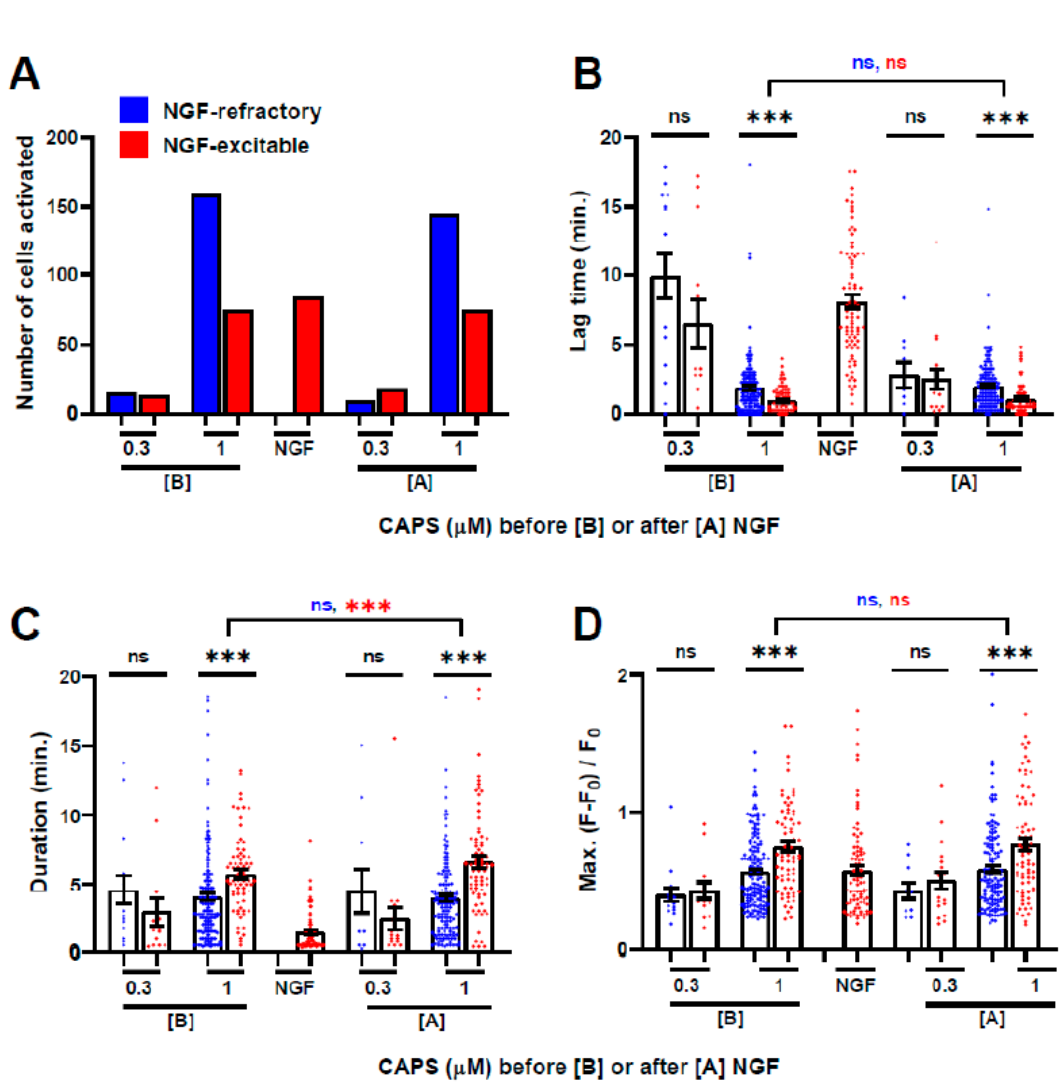
Figure 3. NGF-excitable cells exhibit more robust responses to CAPS. Further analysis was performed on DRG subjected to the protocol described for the red trace in Figure 1A. Cells were categorised according to whether or not they responded to 20 min. with NGF. ( A ) The number of NGF-excitable (red bars) and -refractory (blue bars) cells that responded to each treatment with the indicated CAPS concentrations applied before [B] or after [A] NGF. Analysis tools were applied to each sub-category to measure ( B ) Lag, ( C ) Duration and ( D ) Max. intensity, in all cases plotted as means ± s.e.m., with blue and red dots representing, respectively, values from individual cells assigned to the NGF-refractory and -excitable categories. Black asterisks represent p values derived by unpaired Student’s t-test between the NGF-excitable and –refractory cells within each CAPS stimulation group. Coloured asterisks show results from paired Student’s t-test for measurements of signals evoked by 1 µ M CAPS before and after NGF, respectively, for each cell category; *** p < 0.001; ns, not significant. Full statistical analysis is described in Supplementary Tables S5 and